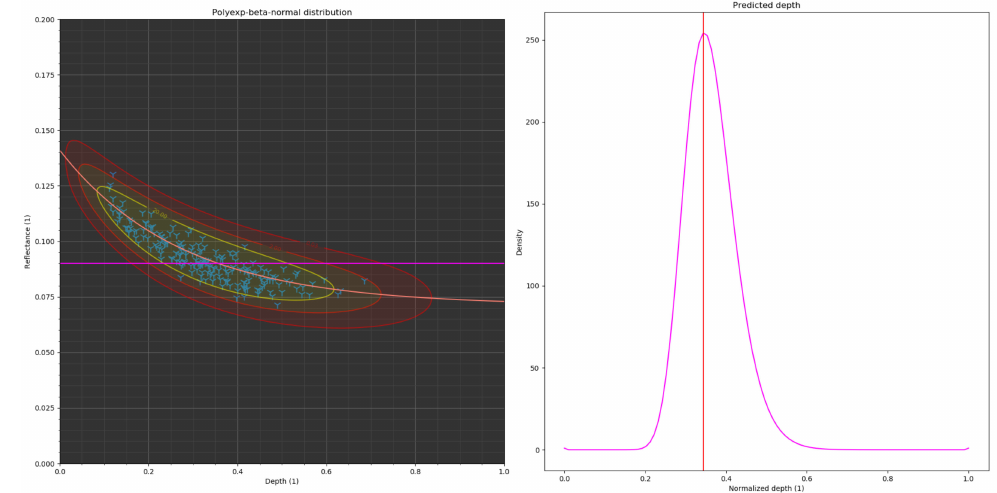
Figure 8. Extraction of probable depth within an ROI polyexp-beta-normal